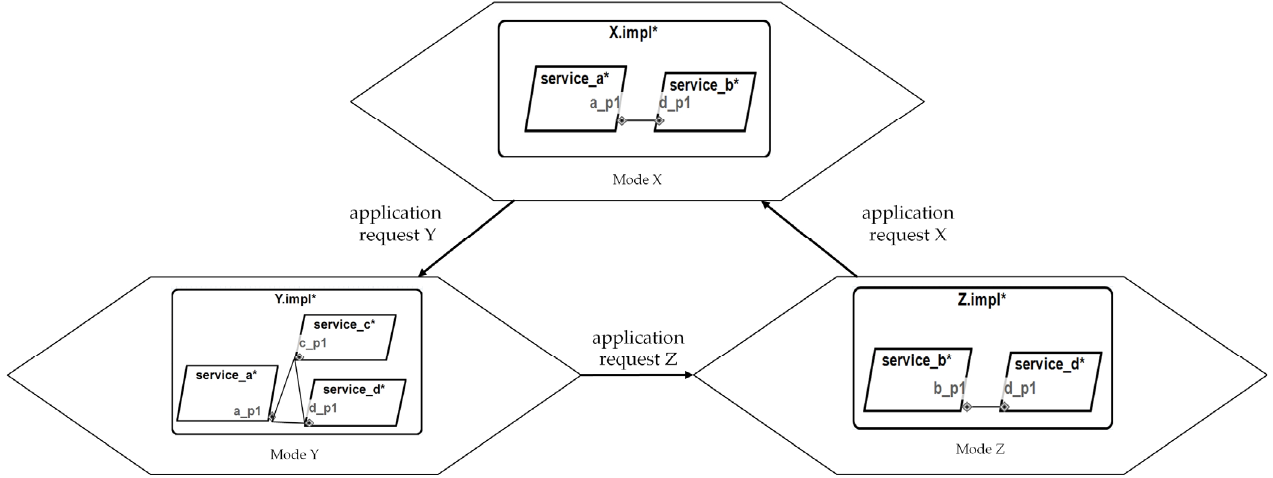
Figure 5. An example of SOA system modeling.